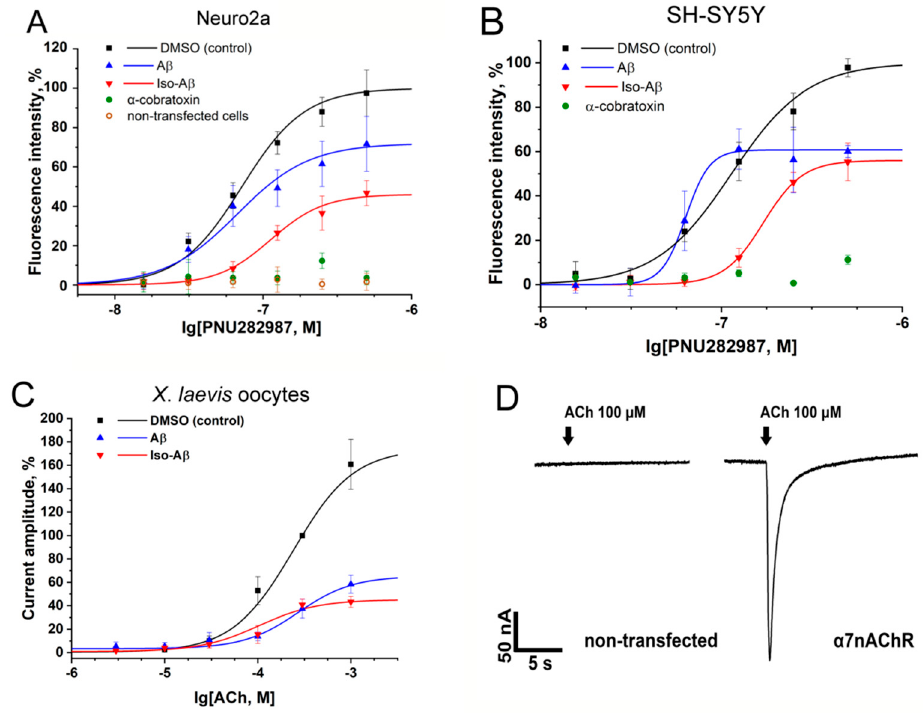
Figure 1. E ff ects of A β 42 and iso-A β 42 on the intracellular Ca 2 + and Ba 2 + rise mediated by the α 7nAChR. Dose-dependent Ca 2 + response to PNU282987 stimulation ( A ) in α 7nAChR-transfected or in non-transfected N2a and ( B ) in di ff erentiated SH-SY5Y cells pre-incubated with 10 µ M of A β 42 or iso-A β 42 for 30 min or with 15 µ M of α -cobratoxin for 15 min. ( C ) Dose-dependent Ba 2 + response in the α 7nAChR-transfected Xenopus laevis oocytes to acetylcholine (ACh) stimulation after 3 min pre-incubation with 10 µ M of A β 42 or iso-A β 42 . ( D ) Electrophysiological recordings of α 7nAChR currents in native (uninjected) and α 7nAChR cRNA-injected oocytes. Currents were obtained in response to 100 µ M ACh application (arrows). Vertical bar represents current scale (50 nA). Data are presented as the mean ± SEM of at least three independent experiments. Table 1. The half maximal e ff ective concentration (EC50) of PNU282987inducing the α 7nAChR– mediated intracellular calcium rise in N2a and SH-SY5Y neuroblastoma cell lines, treated with A β 42 oriso-A β 42 . Data are presented as the mean of at least three independent experiments ± SEM. Cell Line